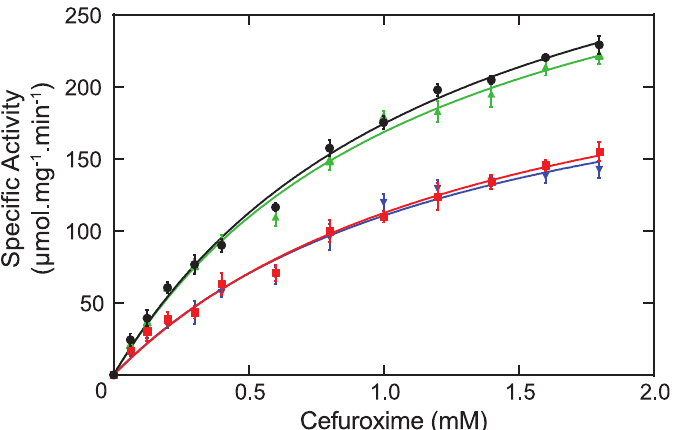
Fig 6. Steady-state kinetics of cefuroxime hydrolysis by different mutants of 5/B/6 MBL confirms 10-mer binding site. Activities of three mutant enzymes were compared with the activity of wild type enzyme, where black is the wild type enzyme, and green, blue, and red correspond to K104Q/K107Q, K78Q, and K78Q/K104Q/K107Q, respectively. The solid lines represent fits to the Michaelis-Menten equation with the resulting kinetic values reported in Table 2. Correlation coefficients (R 2 ) of 0.993, 0.981, 0.990, and 0.978 where obtained for wild type, K78Q, K104Q/K107Q, and K78Q/K104Q/K107Q, respectively. Error bars indicate the standard deviation of five